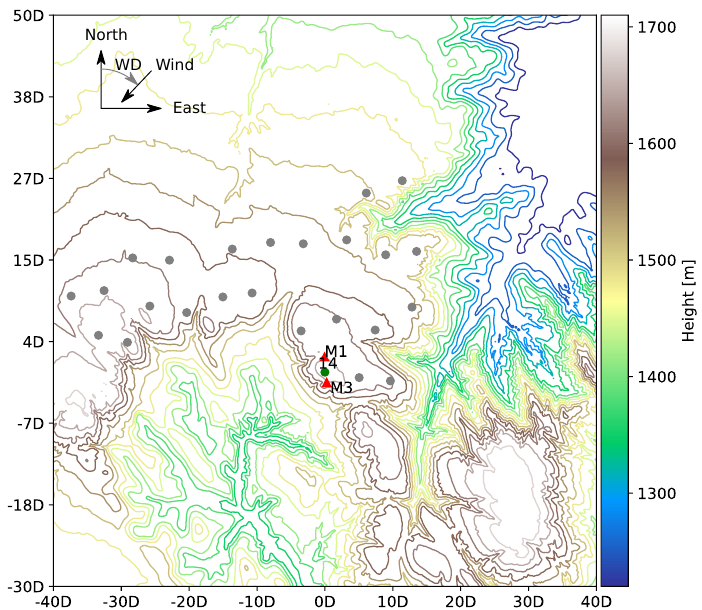
Figure 2. Complex terrain around M1, where Wind direction (WD) stands for the wind direction and D = 93 m is the diameter of wind turbine 14.